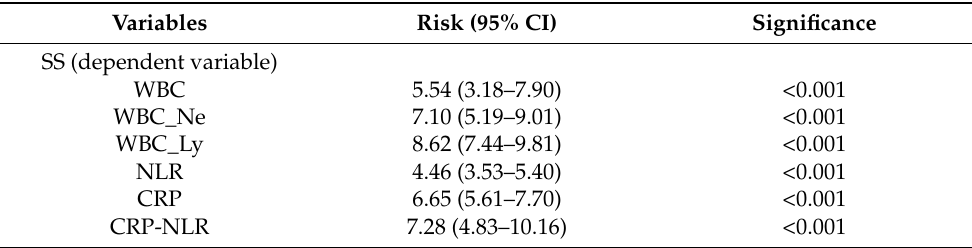
Table 6. Hazard ratios and adjusted odds ratio for SS score calculated at admission for predicting SIRS and sepsis after odontogenic infections.